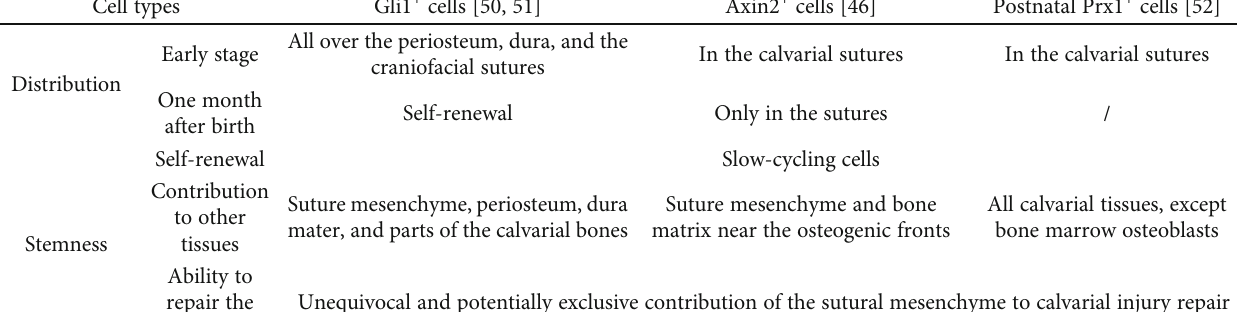
Table 1: The subpopulations of suture mesenchymal stem cells and their characteristics.